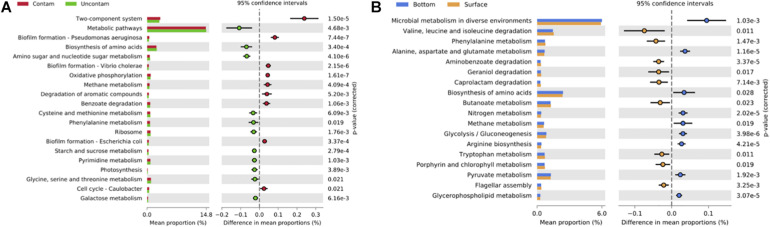
Bar graph representing relative proportions of significant KEGG Pathways at level 3 of SEED metabolic hierarchy in biofilms from contaminated (6ext; red) and uncontaminated (41p; green) sites (A), and in biofilms from surface (yellow) and bottom (blue) (B). Extended error bar plots showed pairwise comparison of significant KEGG Pathway proportions (Welch’s t-test; p < 0.01) at level 3 of SEED metabolic hierarchy between biofilms from contaminated (6ext; red) and uncontaminated (41p; green) sites (A), and between biofilms from surface (yellow) and bottom (blue) (B). Corrected p-value is determined using Fisher’s exact test.